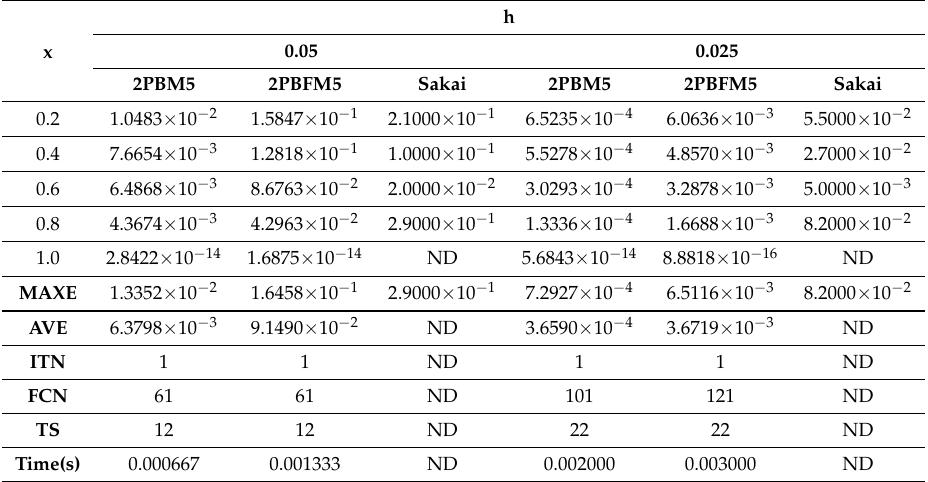
Table 1. The comparison results for Problem 1 at h = 0.05 and h =